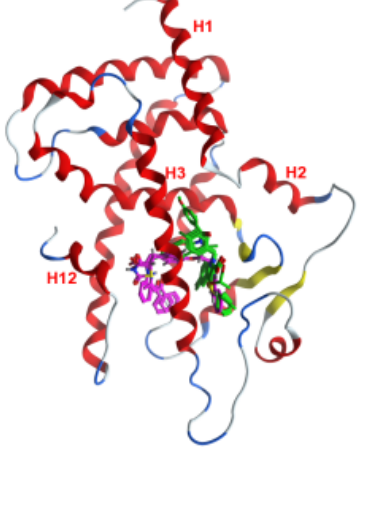
Figure 7. Binding poses of three full agonists (BRL (rosiglitazone), 544 (GW409544) 570 (farglitazar); in magenta) and three partial agonists (MRL24, SR145, SR147; in green) within the PPAR γ binding pocket (template complex